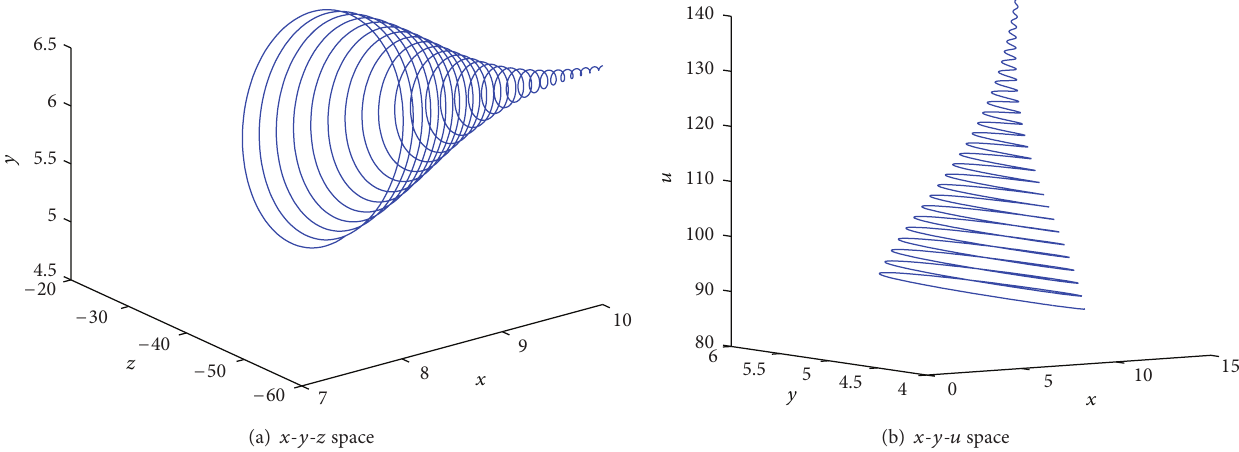
Figure 4: Phase portraits of system (3) for 𝑞 1 = 0.96 , 𝑞 2 = 0.94 , 𝑞 3 = 0.92 , 𝑞 4 = 0.78 , 𝑎 = 3 , 𝑏 = 0.4 , 𝑐 = 0.4 , and 𝑑 = 2.8 .